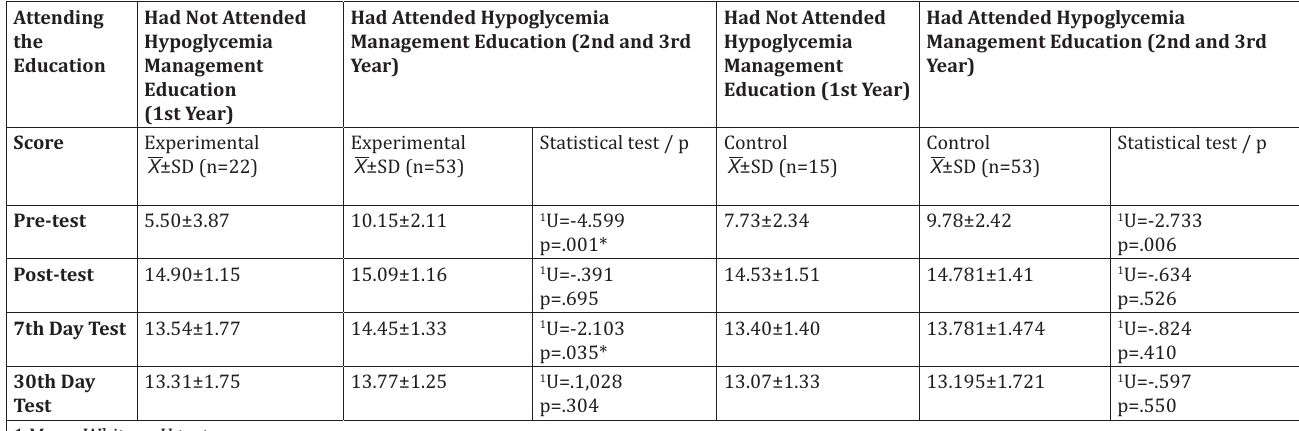
A Comparison of the Mean Scores of the Experimental and Control Group Students Who Had and Had Not Attended the “Hypoglycemia Management” Education by Year of